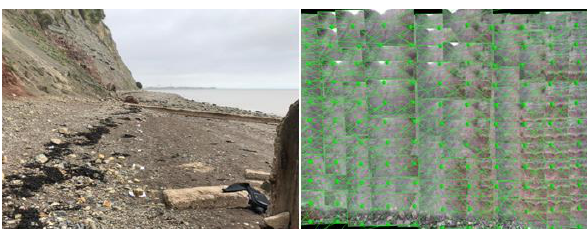
Figure 7. Degree of Overlap from Marked Points on the Ground Poles stations were at every 1.65m marked on the ground with a white paper as shown on the Left-Hand Side LHS of fig. 4.9. The painters’ pole used is 11m long and segmented at every 1m. The average percentage of overlap is 55% horizontal and